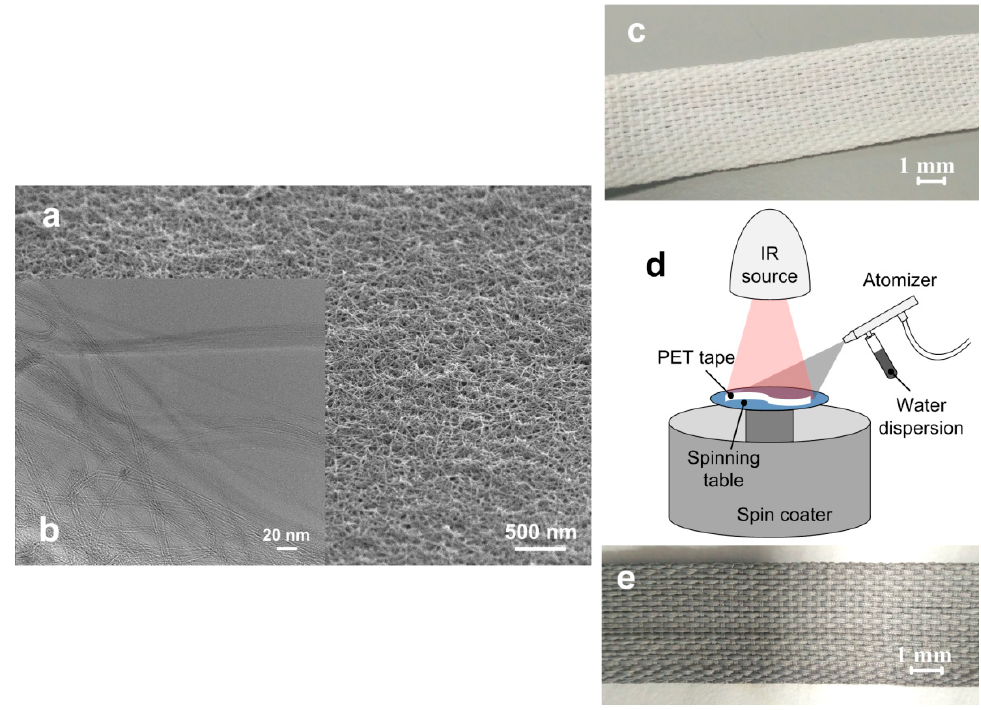
Figure 11. Images of ( a ) the SEM of the SWCNT overview map, ( b ) the TEM of the isolated SWCNT, and ( c ) the appearance of the PET tape fibers, ( d ) the installation diagram for forming the SWCNT/collagen coating on the PET tape and ( e ) the PET tape coated with SWCNT/collagen. To prepare the final dispersion, a collagen suspension and a SWCNT dispersion were mixed and treated alternately with an ultrasonic bath (Sapphire-TTS, Sapphire, Moscow, Russia) and a magnetic stirrer (C-MAG HS4, IKA, Staufen, Germany) for 5 h. During ultrasonic homogenization, the dispersion temperature was controlled in the range of 30–37 °C. The concentration of the final dispersion of SWCNT/collagen in the dispersion was 0.01 wt.% and 2 wt.%, respectively. To form a SWCNT/collagen coating on the PET tape, a spin coater (WS-400, Laurell Technologies, North Wales, PA, USA), and an infrared (IR) radiation source (YLR, IRE-Polus, Fryasino, Russia) were used. Recently, optical methods of forming solid biocompatible nanomaterials from liquids have proven themselves well [91,92]. Using a spin coater, a thin layer of dispersion was applied to the PET tape, which was mounted on a spin coater table. During the rotation of the sample, the dispersion was condensed using an IR source at a temperature of no more than 40 °C (Figure 11d). Then the next layer was applied, and the procedure was repeated. As a result, 5–7 layers were applied (Figure 11e). As a control sample, a ligament implant with a coating of collagen suspension was made (Figure 11c). All experimental and control samples were sterilized by ethylene oxide gas sterilization at 37 °C. Ethylene oxide is an alkylating agent that disrupts cellular metabolism and the reproductive processes of microorganisms. Ethylene oxide penetrates breathable packaging, making contact with all accessible surfaces of the product to deliver the required sterility assurance level. This method of sterilization was chosen because of the possibility of sterilization without exposure to high temperature and damaging the structure of the collagen by high-intensity radiation [93]. The quality control of the sterilization (the lack of growth of control microorganisms) was carried out using biological and chemical multiparameter indicators. As a biological indicator, we used that containing Bacillus atrophaeus spores attached to a strip placed in a container with a nutrient medium (Attest 1264, 3M, St. Paul, MN, USA). Ethylene oxide penetrates the container, killing spores, and thereby confirming compliance with the necessary conditions for sterilization. The chemical indicator is a strip that confirms the quality of sterilization by changing the color from red to green (Comply 1251,